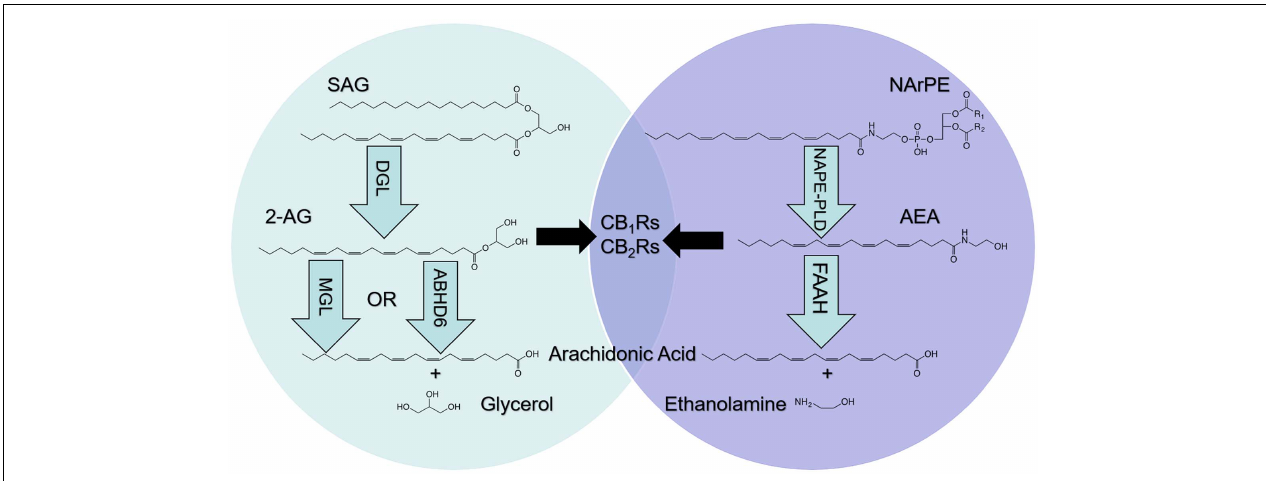
FIGURE 1 | Metabolism of endocannabinoids (eCBs). The eCBs, 2-arachidonoyl- sn -glycerol (2-AG) and arachidonoyl ethanolamide (AEA), activate cannabinoid receptor subtype-1 (CB 1 Rs) and subtype-2 (CB 2 Rs) located in cells throughout the body; however, metabolic pathways are not shared. 2-AG is produced following hydrolysis of the 2-AG precursor, 1, stearoyl,2-arachidonoyl- sn- glycerol (SAG), by diacylglycerol lipase (DGL). 2-AG is degraded by monoacylglycerol lipase (MGL) and alpha/beta hydrolase domain-6 (ABHD6) into arachidonic acid (AA) and glycerol (left). AEA is produced following hydrolysis of the AEA precursor, N -arachidonoylphosphatidylethanolamide (NArPE), by N -acylphosphatidylethanolamide phospholipase D (NAPE-PLD). AEA is degraded by fatty acid amide hydrolase (FAAH) into AA and ethanolamine